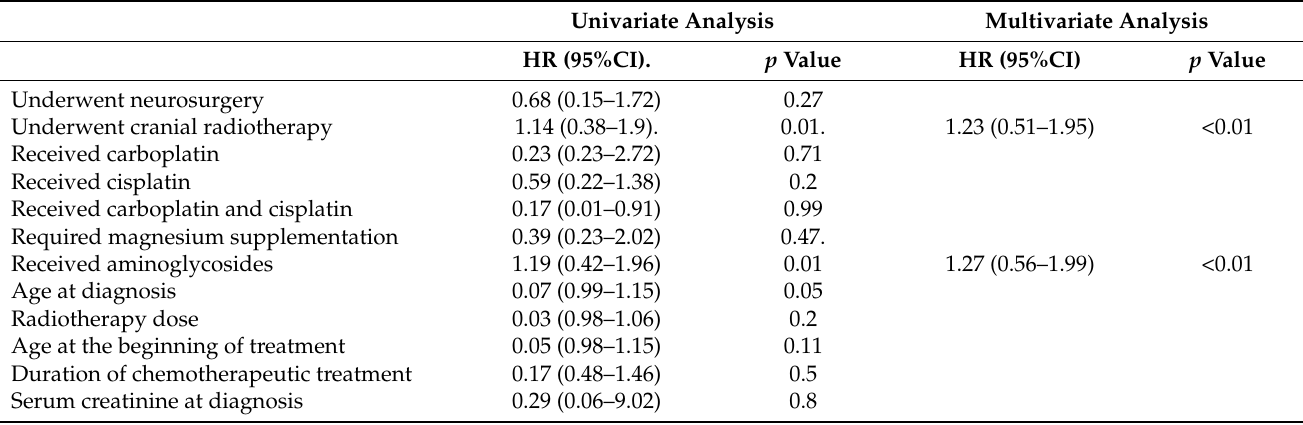
Table 4. Univariate and multivariate analysis of the onset/progression of acoustic damage in the 5 years following the conclusion of treatment.